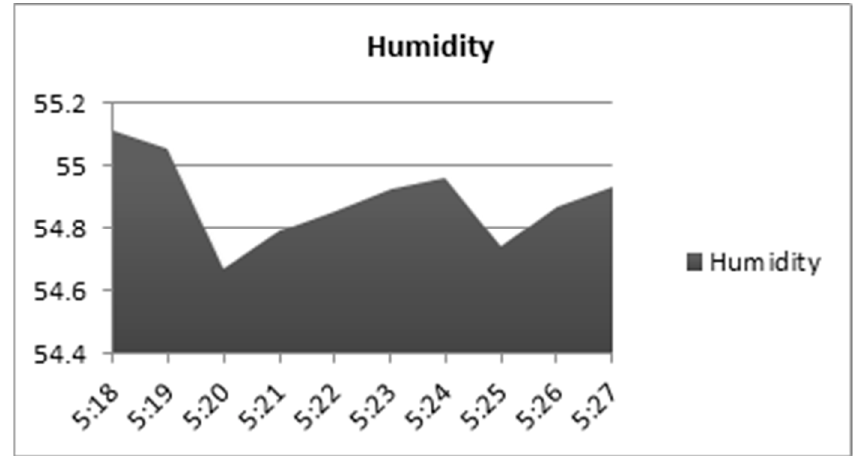
Figure 12. Room humidity level over time.